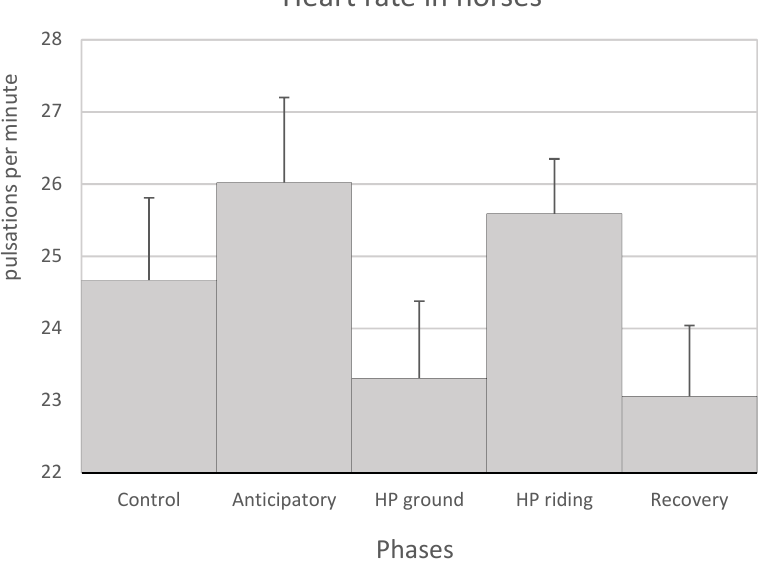
Figure 1. Mean values + SEM of the heart rate of the horses in the control and the anticipatory phases, the HP ground and HP riding phases (horse-patient interaction on the ground and on horseback, respectively) and the recovery phase. No significant differences were observed between the phases.